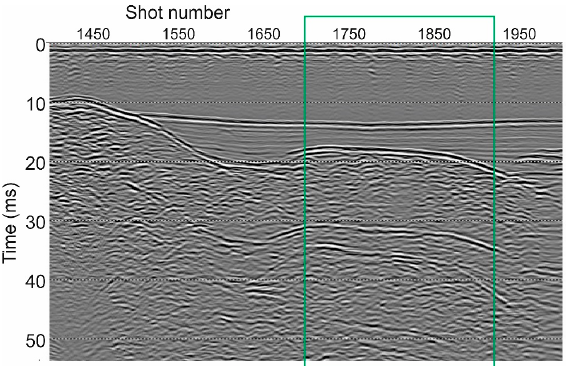
Figure 7. Seismic section acquired at the Cavazzo Lake (Eastern Alps, Italy), using a Boomer system. The green rectangle displays the region where primaries and multiples were picked and inverted, from shot point 1697 to 1931.